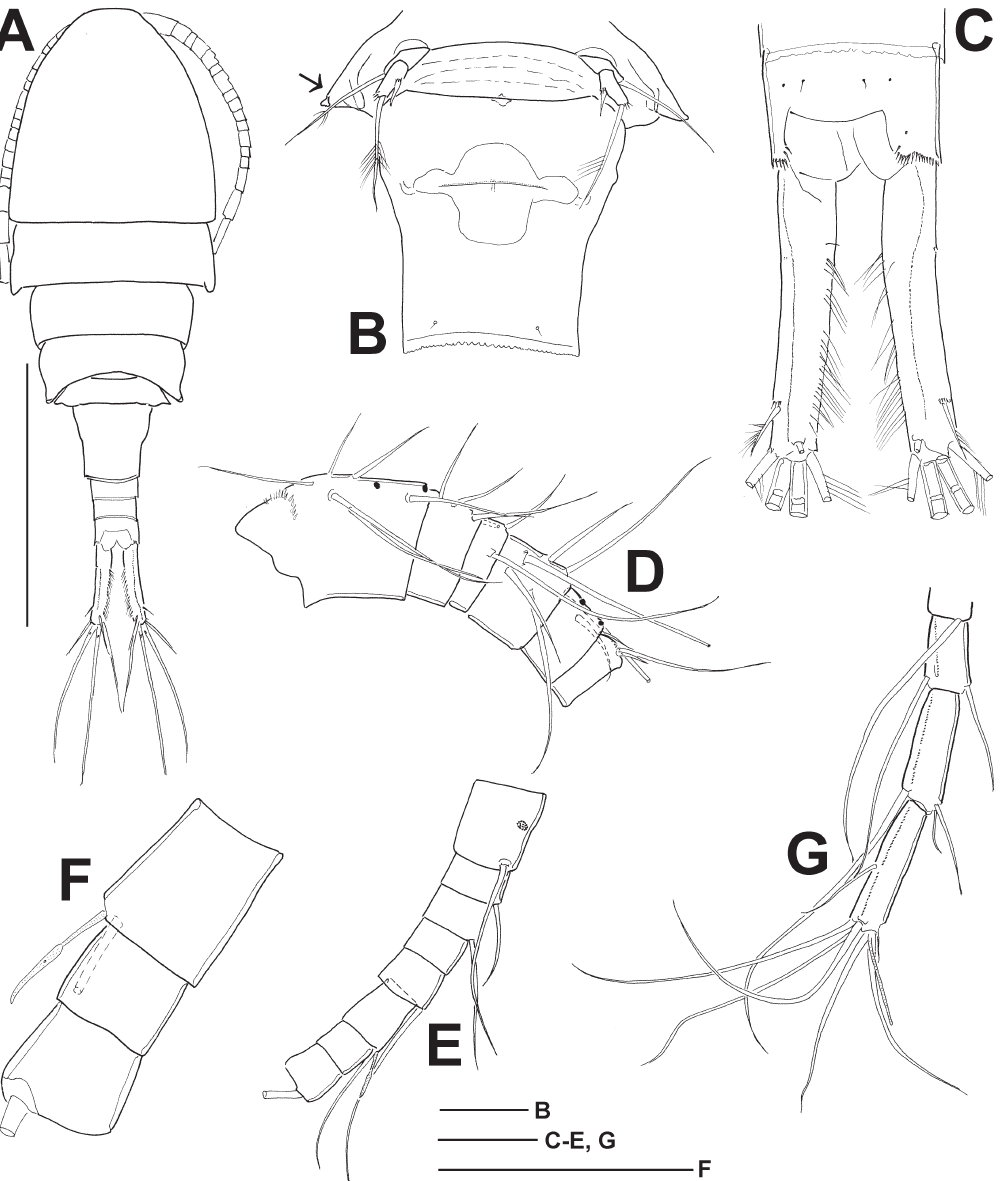
Fig. 1. Cyclops bohater koźmiński, 1933, ♀. A . Habitus, dorsal. B . Pediger 5 and genital double- somite, ventral, arrow points to lateral “wing-like” protrusion of pediger 5. C . anal somite and caudal rami, dorsal. D−G . antennule, ventral. D . segments 1−6 (i−Xiv). E . segments 7−14 (Xv-XXiii). F . segments 12−14 (XXi−XXiii). G . segments 15−17 (XXiv−XXviii). except for a (nHmUk 2016. 39) all drawings show the lectotype (nHmUk 2016. 38). scale bars: a = 1 mm; B−G = 100